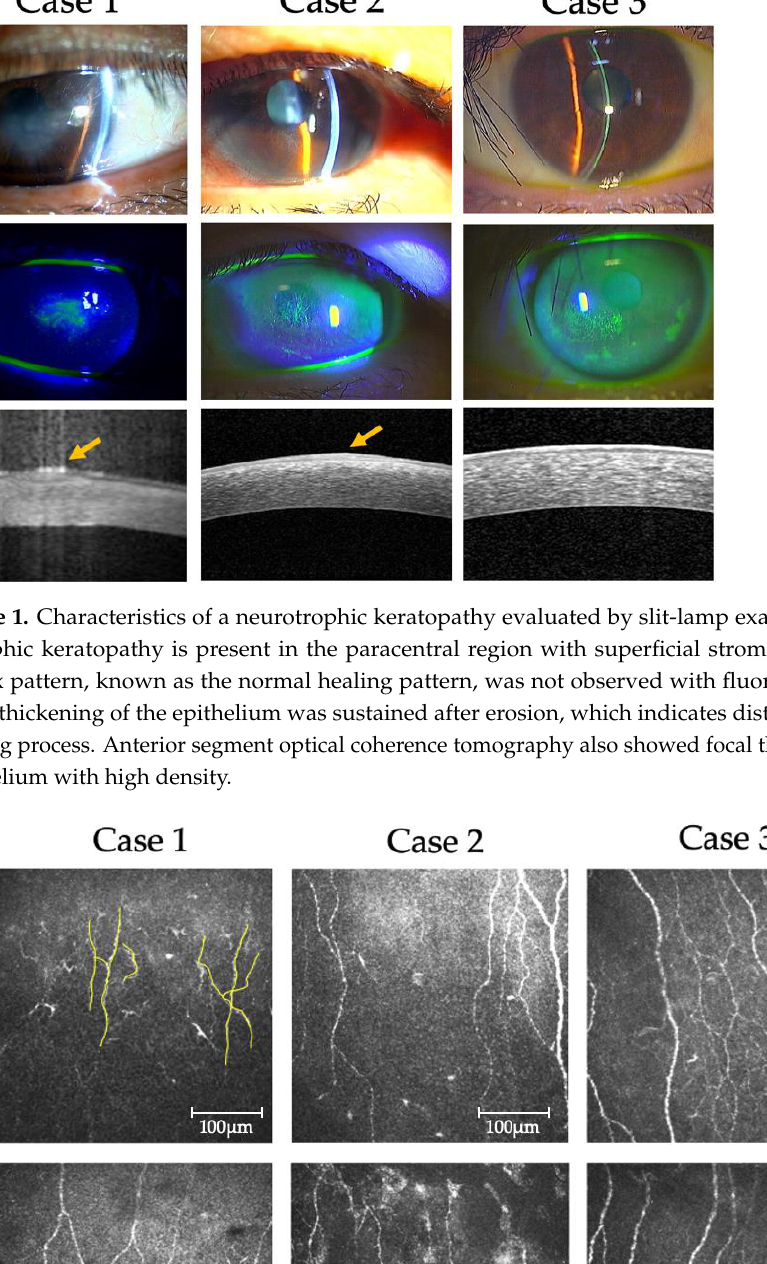
Table 2. Comparison of both corneas by IVCM (analysis of variance : ANOVA).